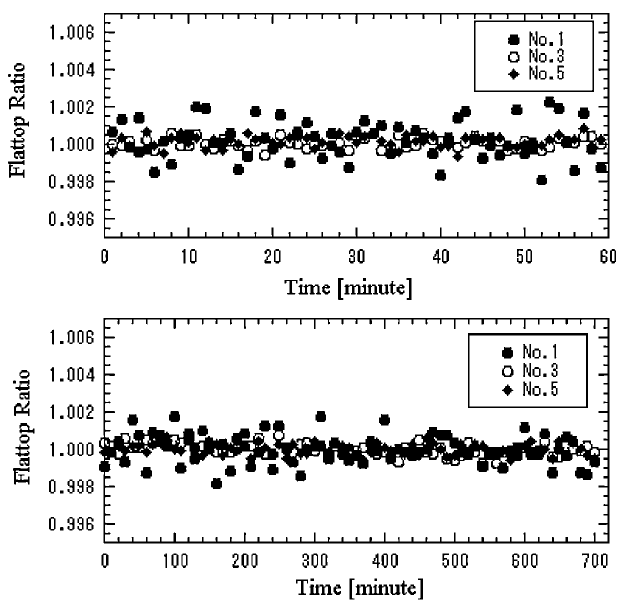
FIG. 9. Stability of the output current during one hour (the upper panel) and eight hours (the lower panel).